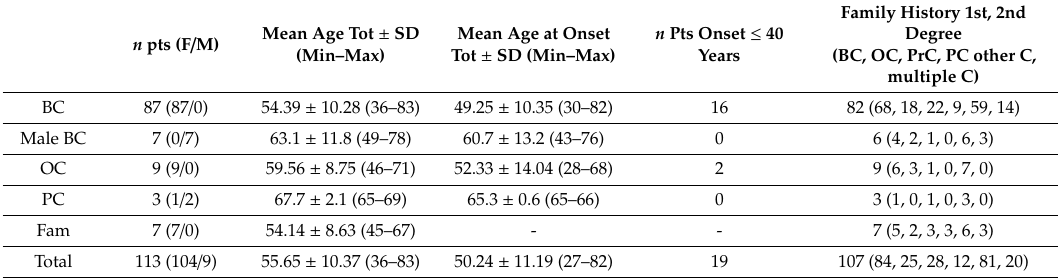
Table 2. Main clinical variables of the study